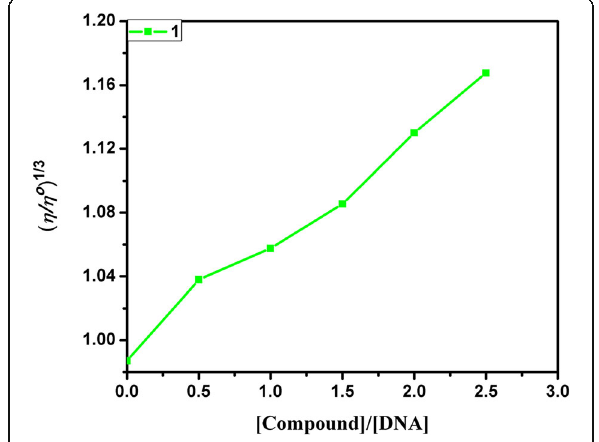
Fig. 3 Cyclic voltammograms of 3.2 × 10 − 4 M of test compound 1 in 1 mM tris-buffer, pH 7.5 at 50 mV s − 1 scan rate without DNA (red) and with DNA